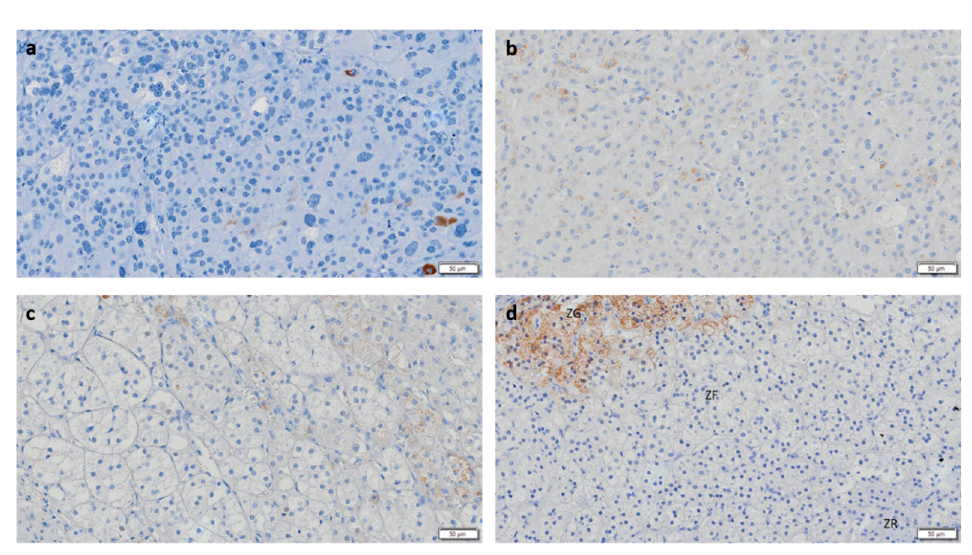
Figure 4. Immunohistochemistry staining for CYP11B2 (Scale = 50 μ m). ( a ) Adrenocortical carcinoma, ( b ) adrenocortical adenoma with Cushing’s syndrome, ( c ) non-functioning adrenocortical adenoma, and ( d ) normal adrenal gland. ZG – zona glomerulosa; ZF – zona fasciculata; ZR – Zona reticularis.